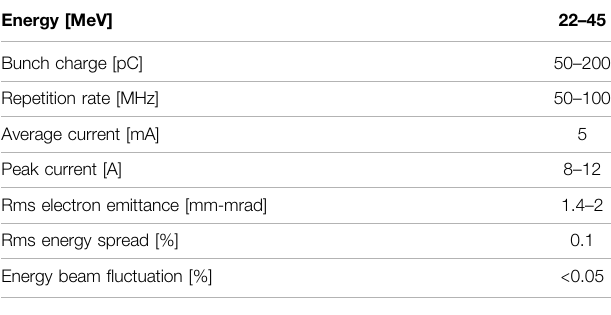
TABLE 3 | BriXSinO electron beam parameters.